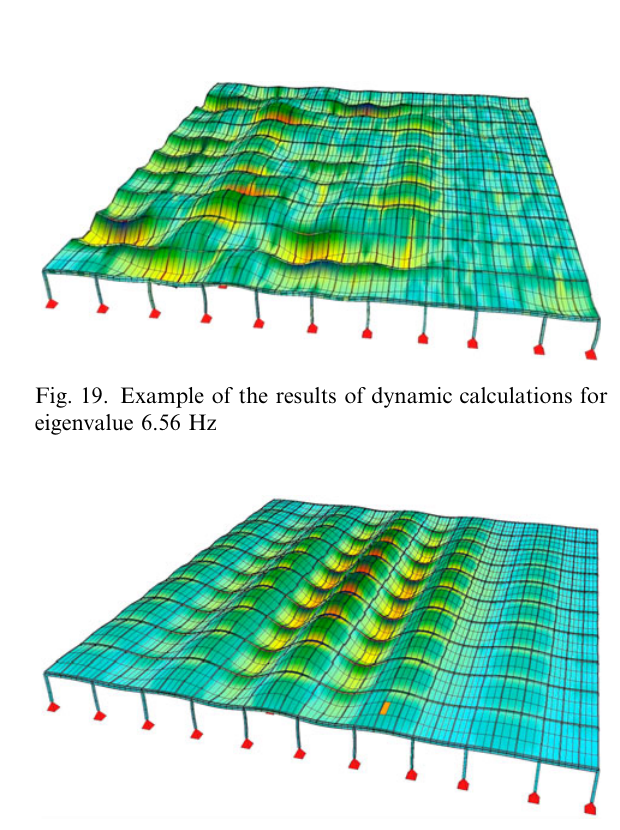
Fig. 20. Example of the results of dynamic calculations for eigenvalue 5.91